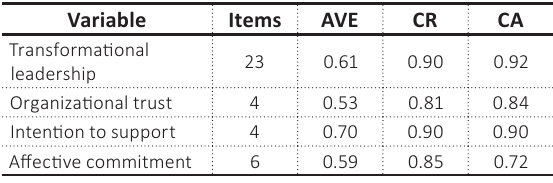
Table 2. Reliability tests